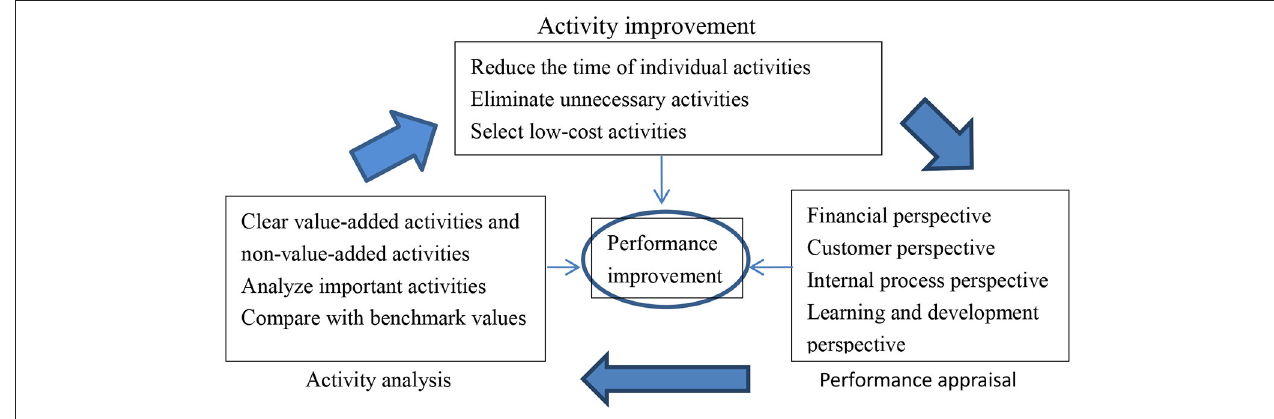
FIGURE 2 | The conceptual framework of time-driven cost